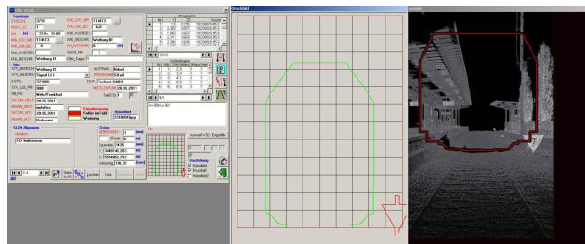
Figure 14: Evaluation of a clearance narrow point with WinLUE . Left: “LUE” information. Middle: “G2” profile and the sign that violates the clearance. Right: Screenshot of the point cloud